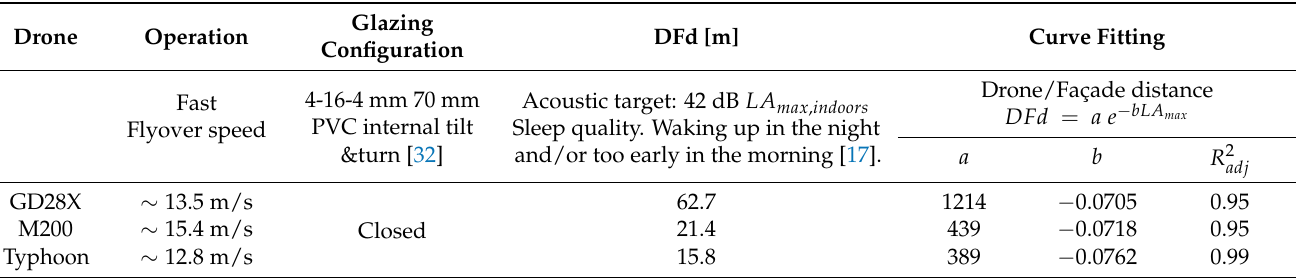
Table 3. Estimation of the optimal drone/façade distance DFd for the tested drones at fast